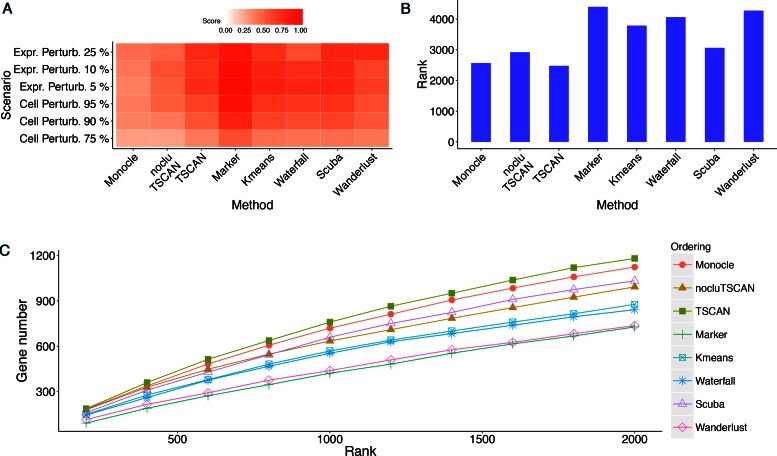
Evaluation results for different methods in qNSC data set. (A)
Robustness measured by the average similarity score from 100 independent
perturbations. (B) Mean rank of gold standard genes. (C)
Number of detected gold standard genes among top differential genes.